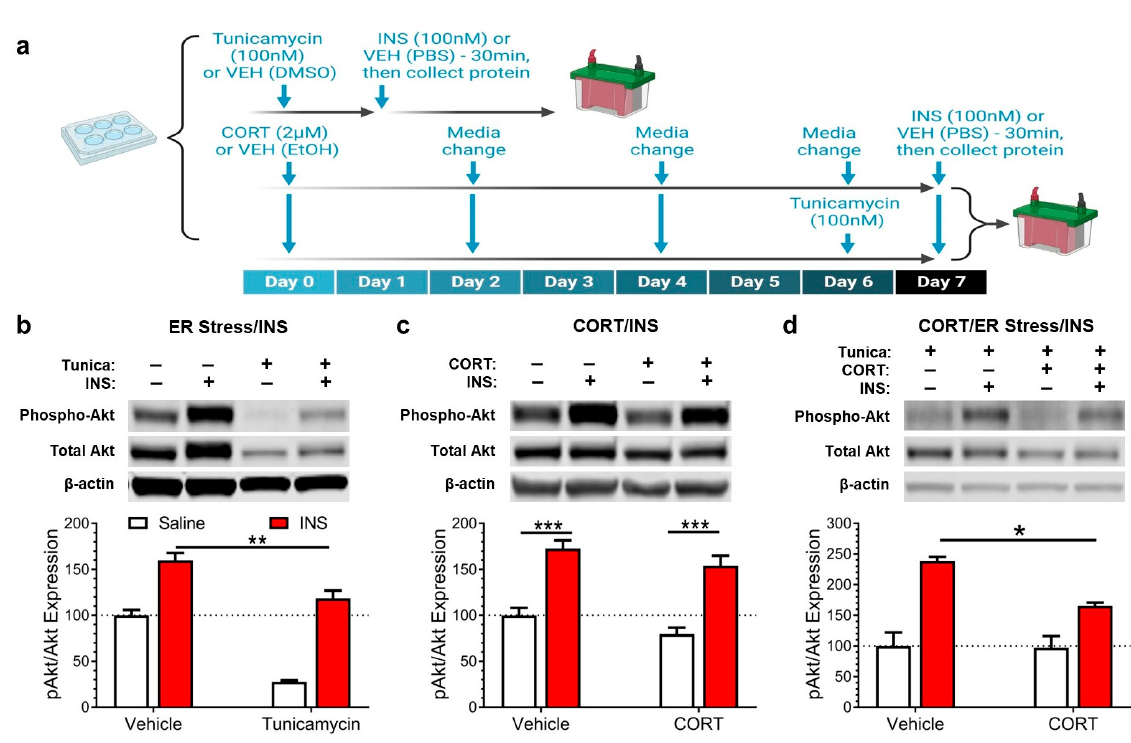
Figure 2. Endoplasmic reticulum stress impairs insulin signaling in mHypoE-44 cells, an effect